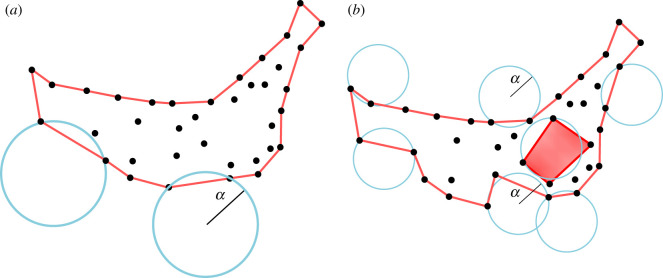
Sketch illustrating the two-dimensional α-shape method for border identification. Given the set of points and a circle of radius α, the circle is moved in the set of points. When the circle touches two points they are considered border points if there are no other points inside the circle. When the circle’s radius is progressively reduced the algorithm is able to discriminate (a) external borders or (b) internal borders (red shaded area is now excluded) and concavities.